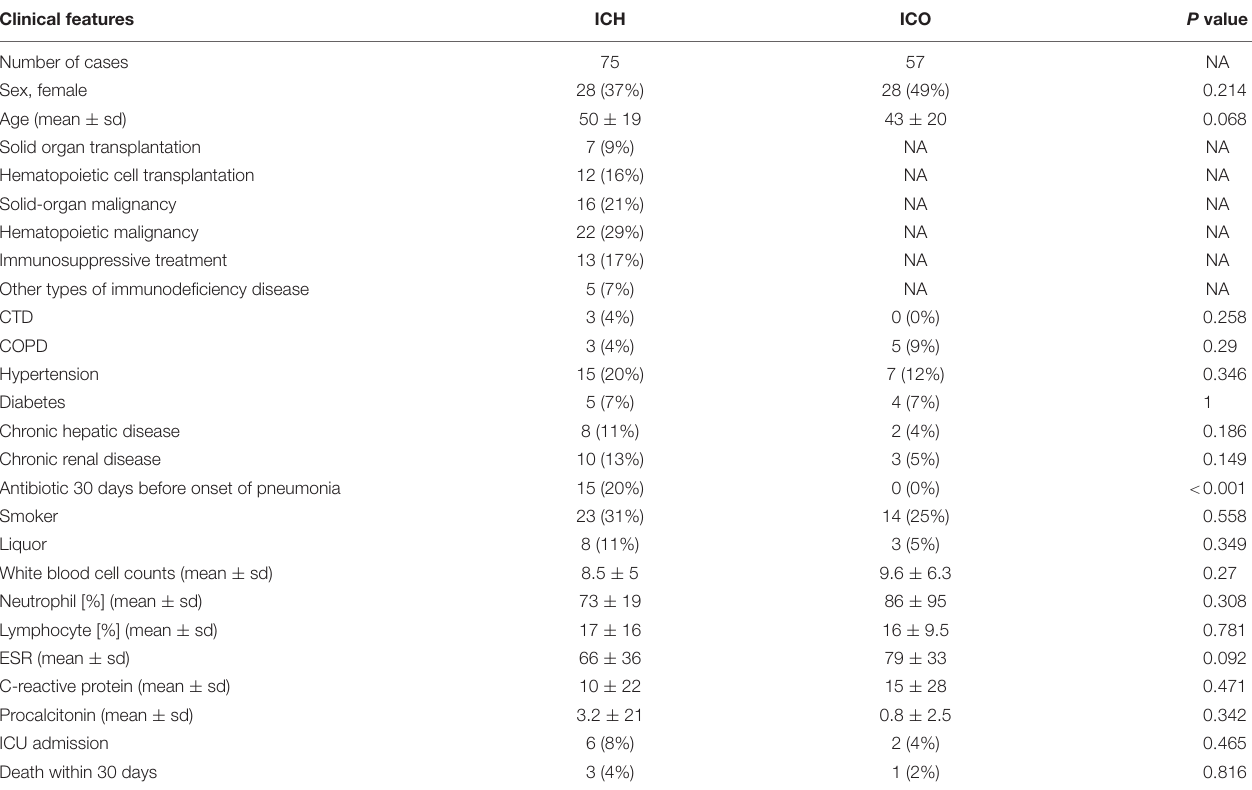
TABLE 4 | Demographic data and underlying conditions of immunocompromised and immunocompetent patients with pneumonia. Clinical